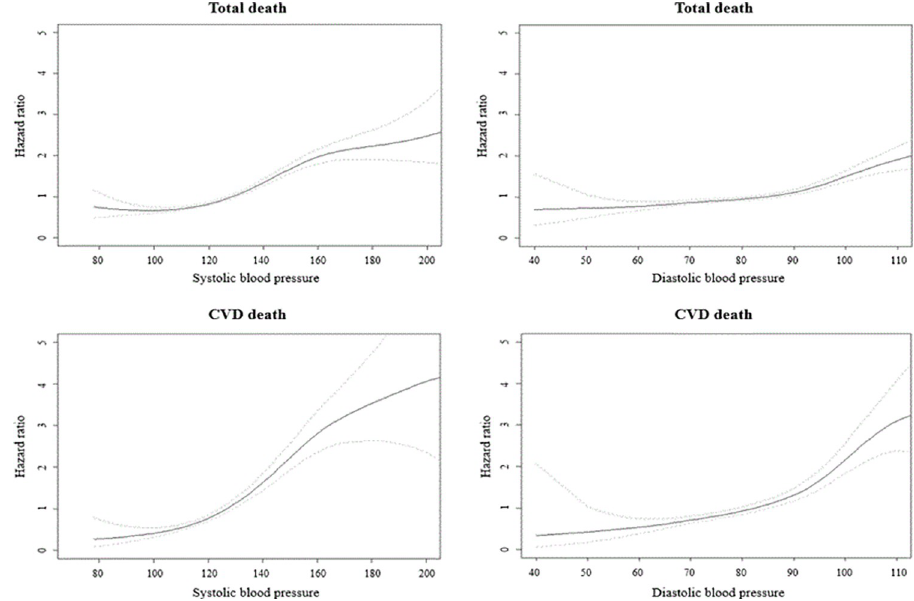
Fig 3. Spline graph to visualize the effect of systolic blood pressure and diastolic blood pressure on the risk of death from all-cause and CVD. (Abbreviation: CVD, cardiovascular disease).